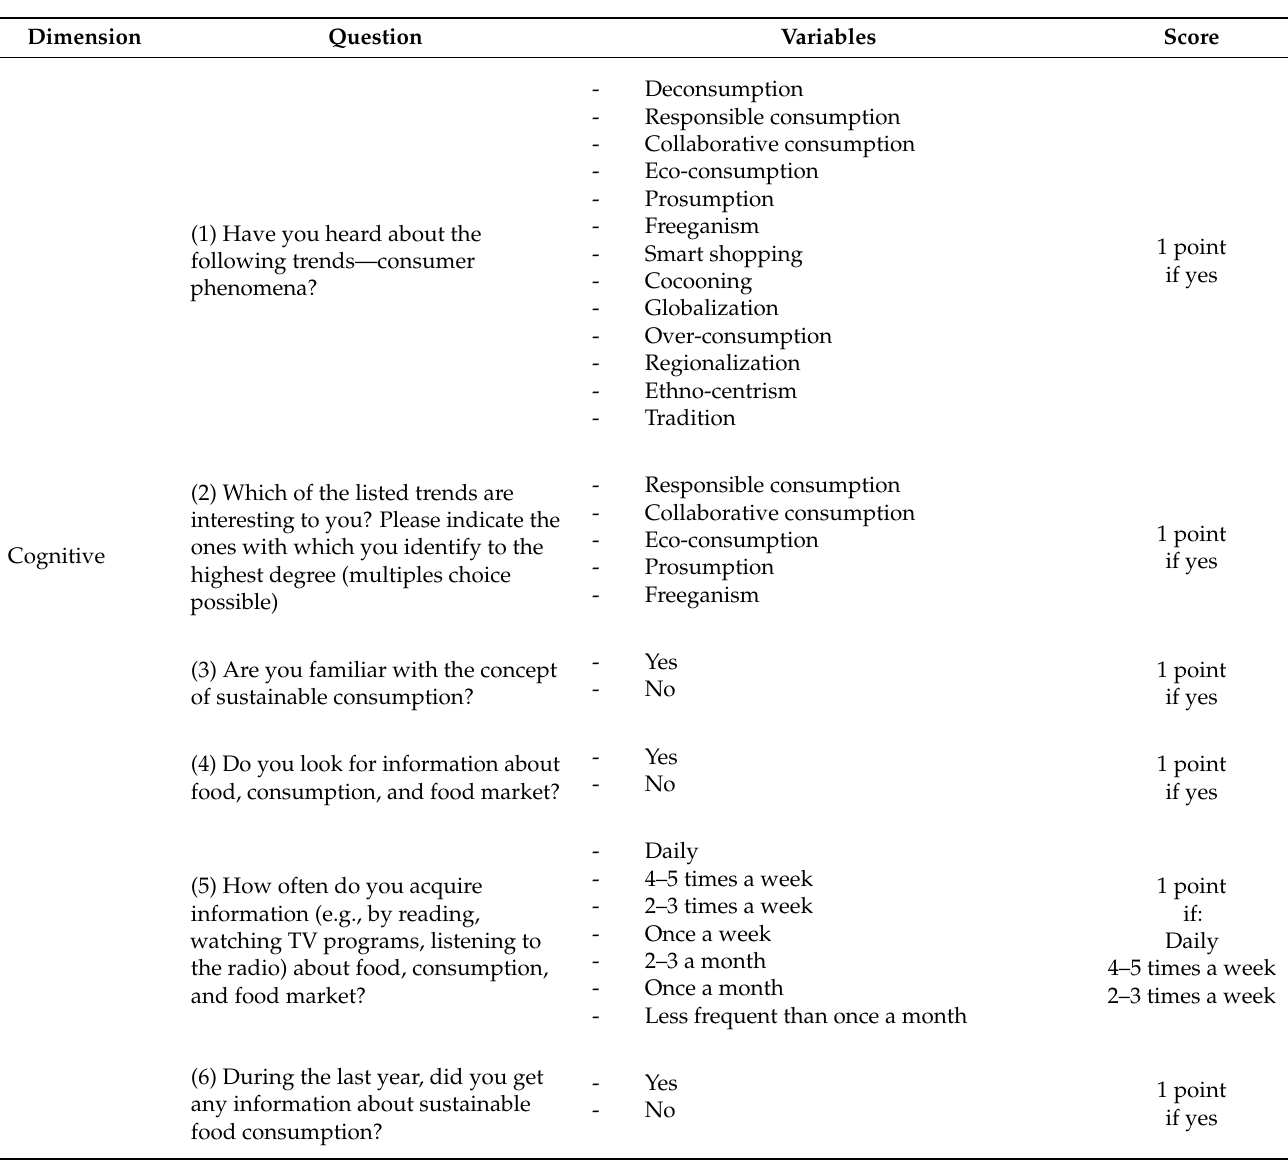
Table 6. Segmentation variables used for the